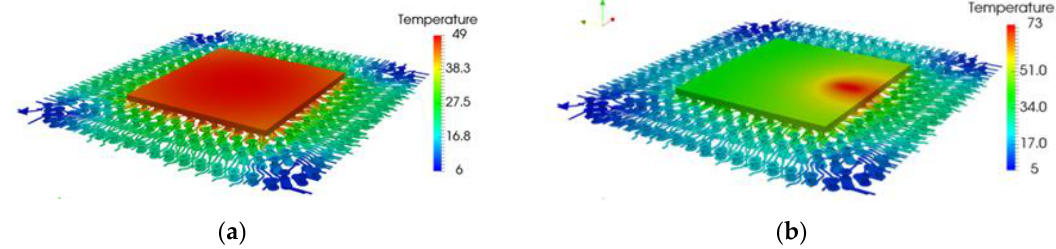
Figure 9. Sensitive temperatures encountered by the chip with uniform power dissipation ( a ) and localized on a peculiar area ( b ).